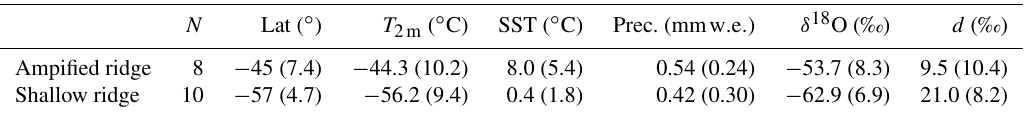
Figure 14. Isotopic composition of precipitation from MCIM with arrival level at 500hPa (red circles) and ECHAM5-wiso for the same days (green circles) plotted against the measurements. The black line marks the line of equal values: (a) δ 18 O and (b) deuterium excess. Table 1. Average values (with standard deviations in brackets) of the estimated source latitude and observations at Dome F of 2m temperature, the estimated SST, observed precipitation, deuterium excess, and δ 18 O in precipitation for two different types of precipitation events. N is the number of days on which the event occurs.